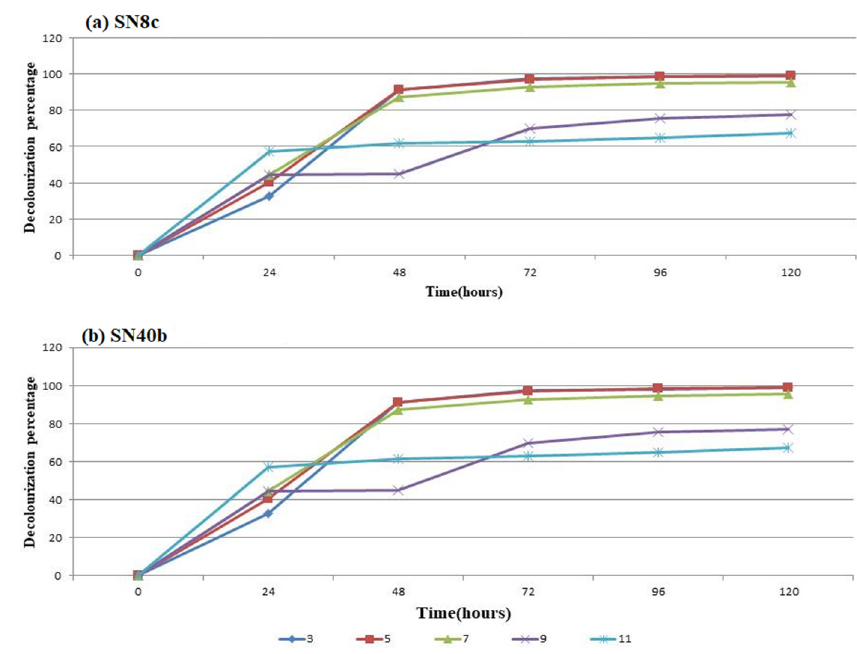
Figure 2. The effect of pH on RBB dye decolorization for ( a ) SN8c, and ( b ) SN40b .